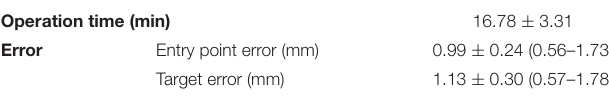
TABLE 3 | Data for robotic biopsy